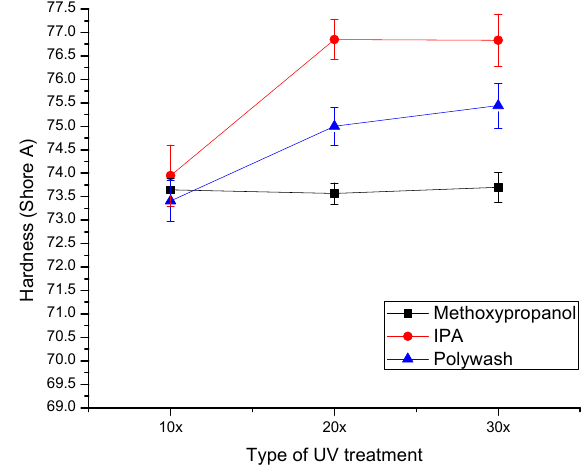
Figure 4. Hardness of the modified photopolymer printing plate samples after exposure to solvents.